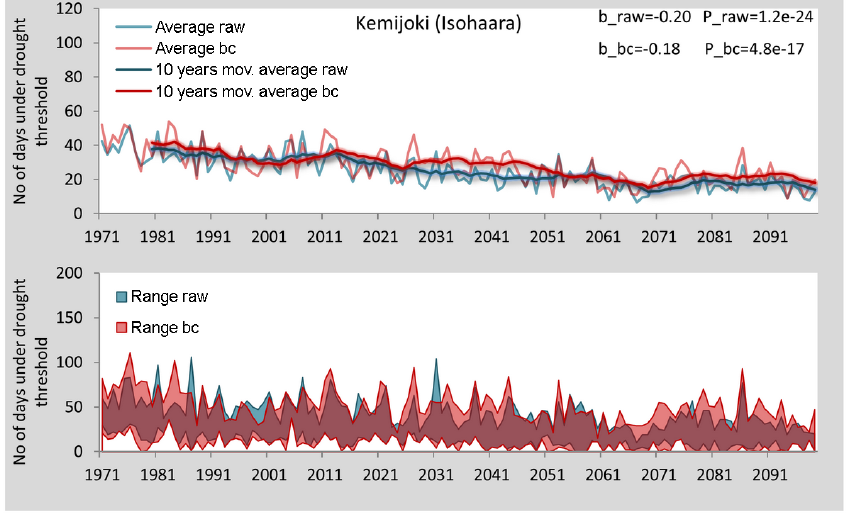
Figure 7. Number of days under drought threshold per year for raw and bias adjusted Euro-CORDEX data. Ensemble mean and 10-year moving average of the ensemble mean (top panel) and ensemble range (bottom